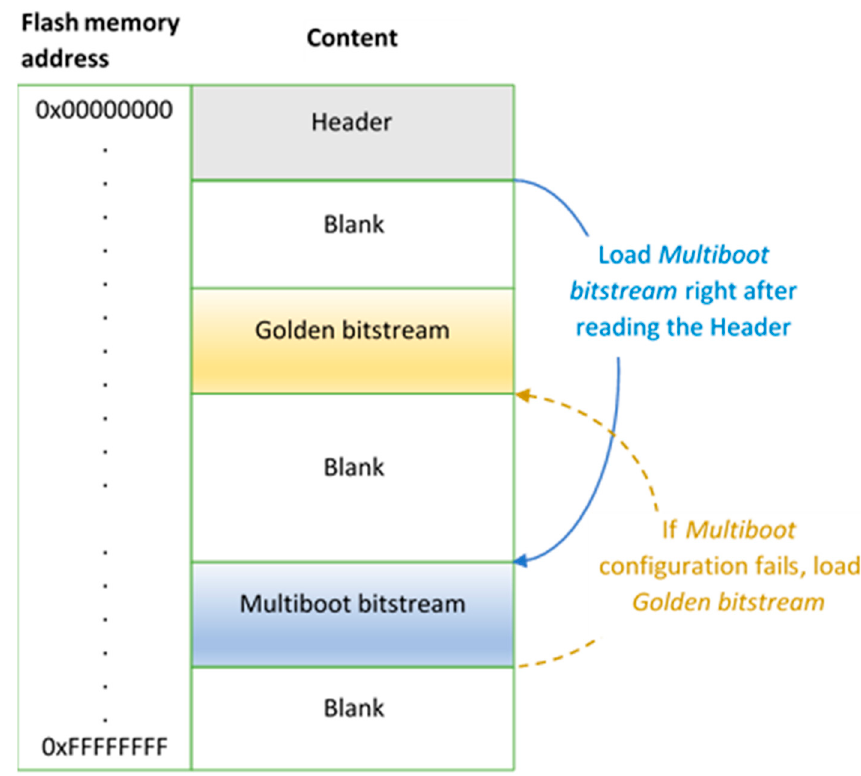
Figure 3. Multiboot configuration process [41].